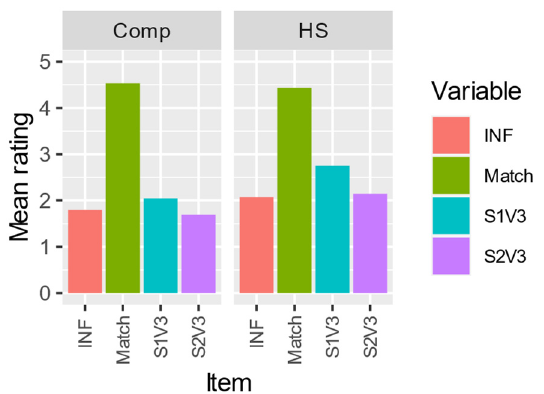
Figure 2. Mean ratings for infinitival, matching and mismatching forms by group.